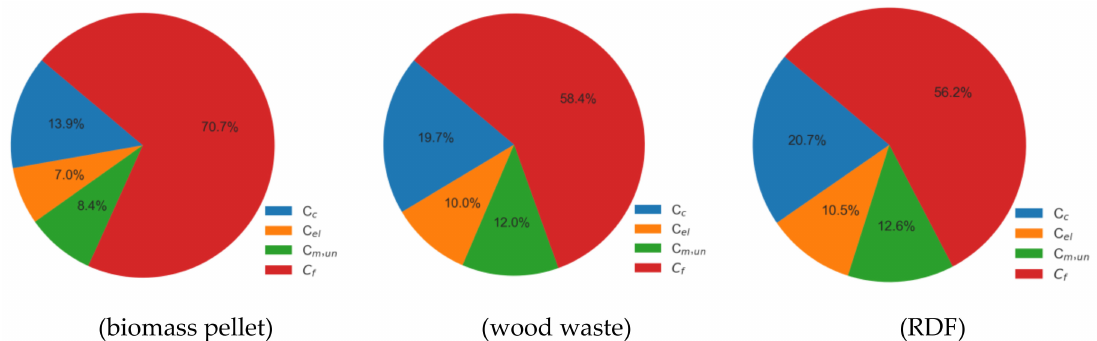
Figure 8. Life cycle cost contribution for 30 kW biomass boiler; C c: capital cost, C el : electricity cost, C m,un : maintenance + unseen cost, C f : fuel cost.